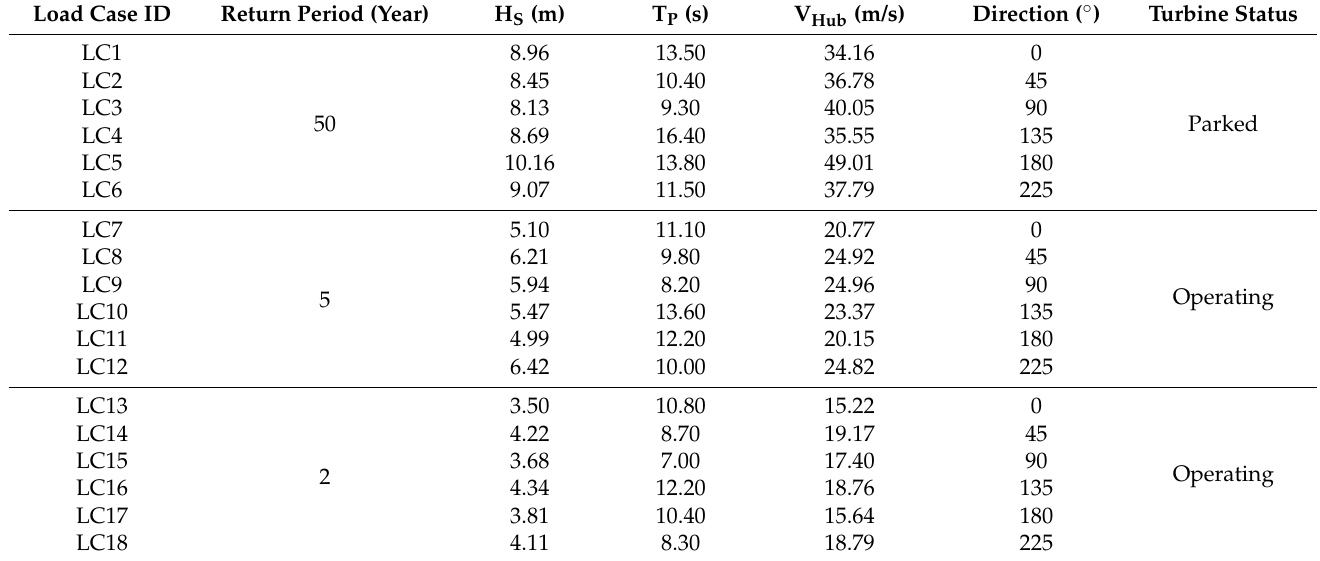
Table 7. The main characteristics of the wind and wave conditions for the considered load